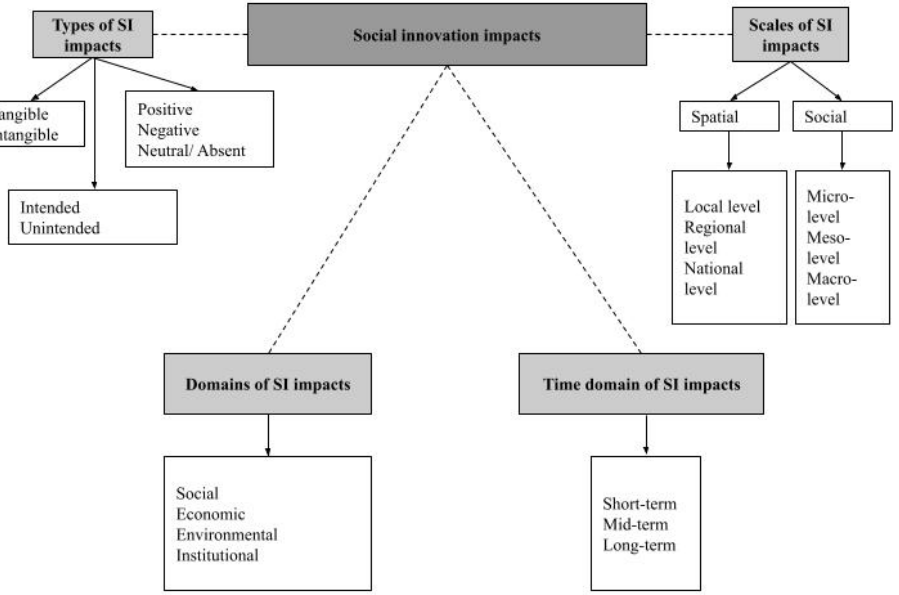
Figure 2. Analytical framework for social innovation impacts. Source: author’s own elaboration, based on (Nicholls et al. 2015; Ravazzoli et al. 2021; Cunha and Benneworth 2020).